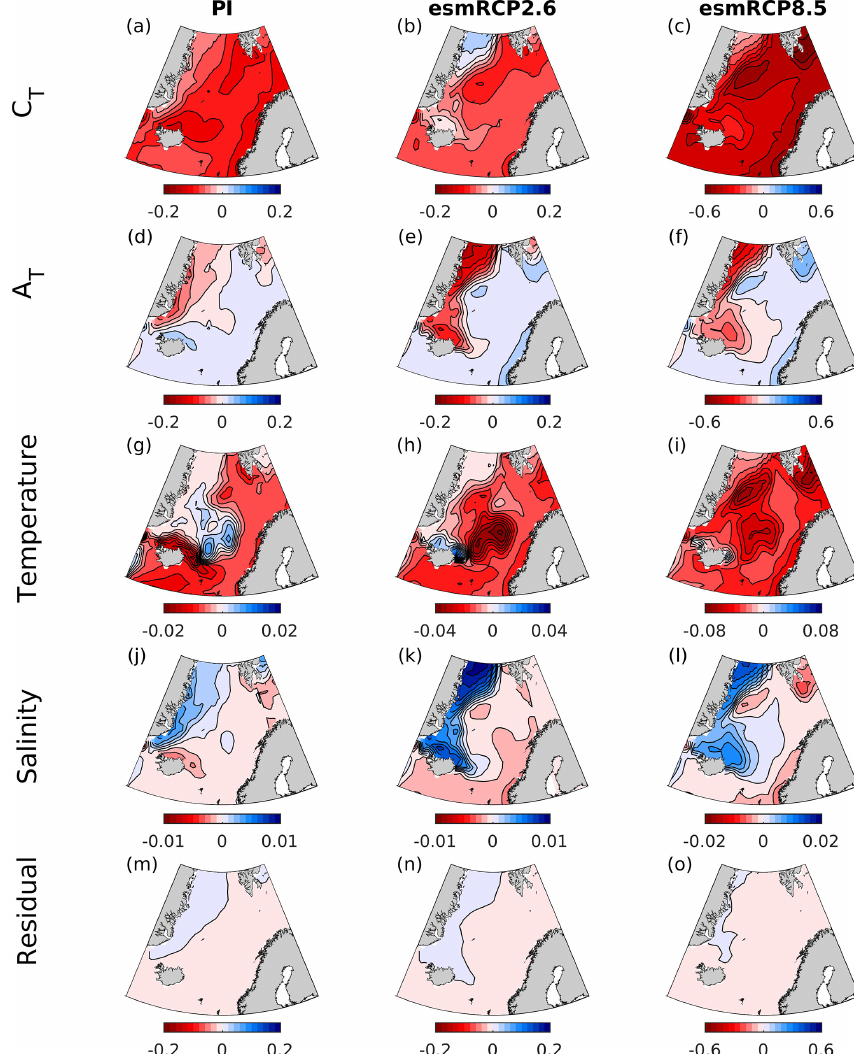
Figure 14. Contribution of modeled changes in surface C T , A T , temperature, and salinity to the change in pH between 1850–1859 and 1996– 2005 (PI) and 1996–2005 and 2090–2099 (esmRCP2.6 and esmRCP8.5). The residual indicates the difference between the total change in pH, calculated as the sum of the trends associated with these four driving factors, and the actual change shown in Figs. 5, 9, and